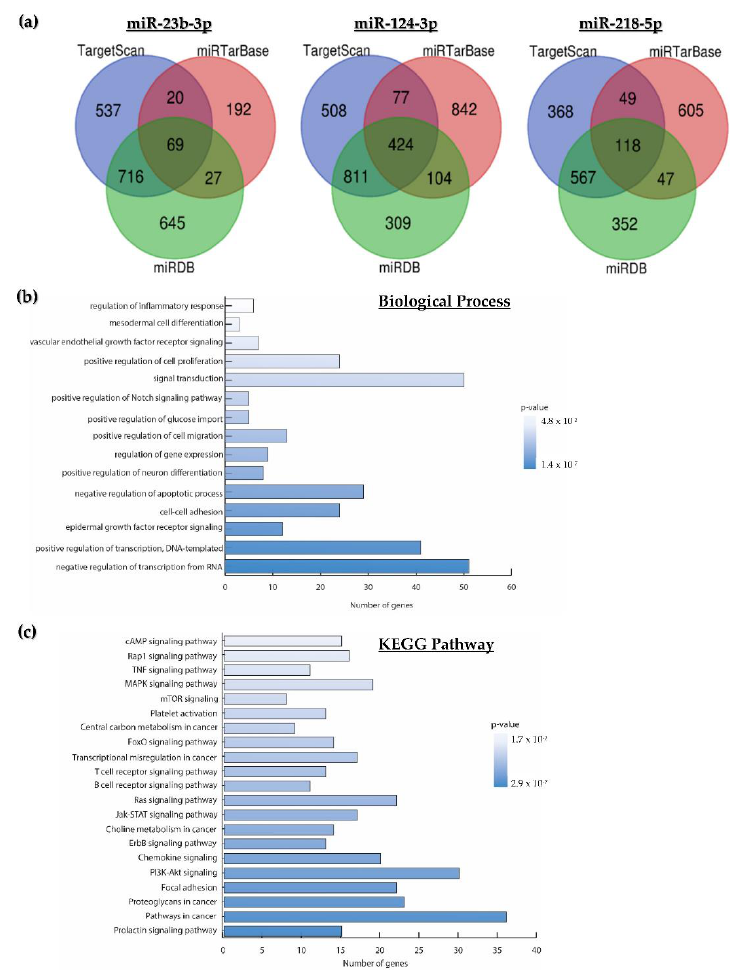
Figure 2. Predicted target mRNAs for miR-23b-3p, miR-124-3p, or miR-218-5p and functional analysis. Overlapping transcripts were predicted using the TargetSan, miRTarBase, and miRDB tools. ( a ) Predicted targets for miR-23b-3p, miR-124-3p, or miR-218-5p; ( b ) biological processes; and ( c ) signaling pathways significantly enriched by the target mRNAs of miR-23b-3p, miR-124-3p, and miR-218-5p .